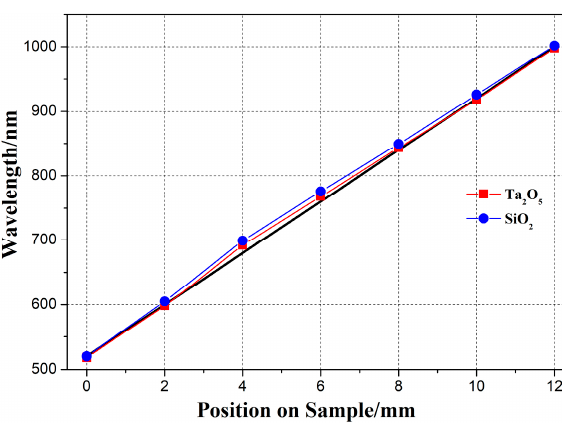
Figure 6. Linear change rate of the thickness of the two materials after match correction.